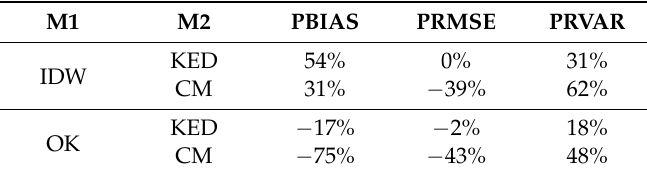
Table 7. The average relative improvement when comparing IDW and OK with geostatistical techniques (KED and CM).